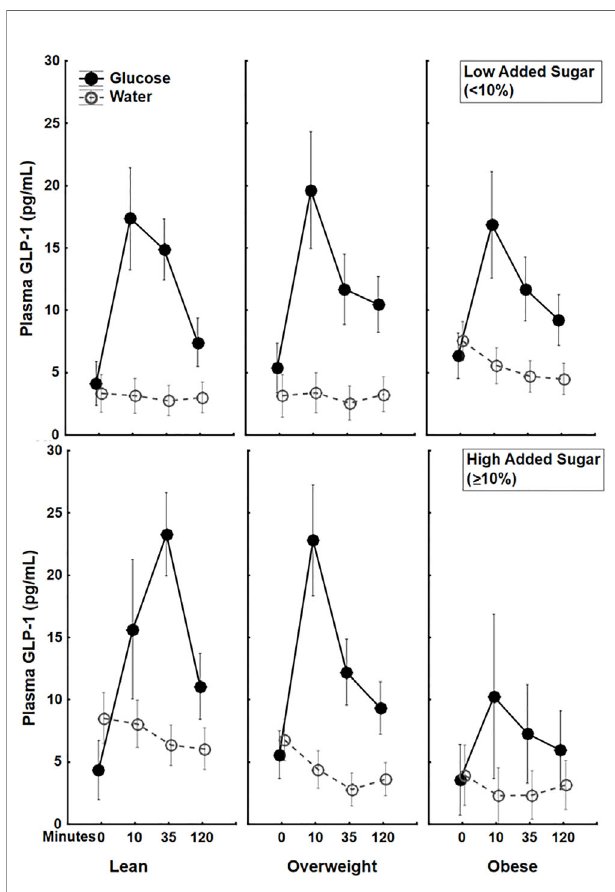
FIGURE 2 | Plasma 5(pg/mL) trajectories in response to glucose (75 g) (closed circles) or water (open circles) drink strati fi ed by both BMI status and Dietary Added Sugar intake. The additive effect of BMI and dietary added sugar are particularly apparent among individuals with obesity who consumed high levels of dietary added sugar ( ≥ 10%)*. *The World Health Organization and the US Department of Health and Human Services recommended that daily intake of added sugars should account for less than 10% of the total calories consumed